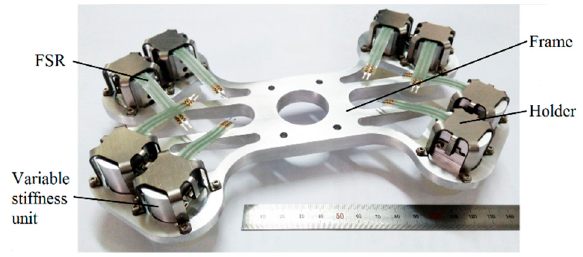
Figure 8. The prototype of the stiffness-adjustable foot system.